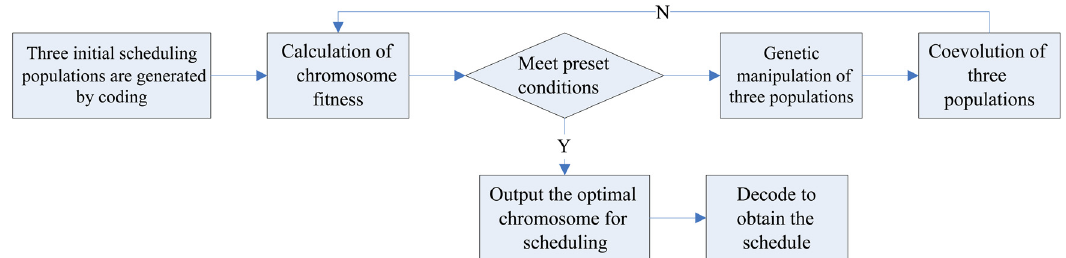
Figure 1: The improved